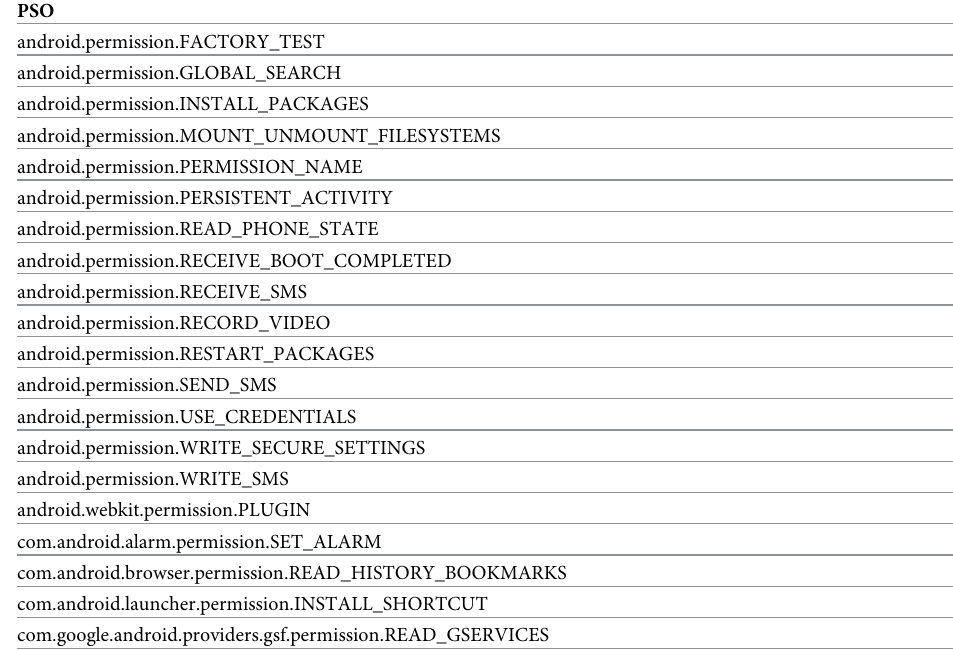
Table 6. 20 features selection of